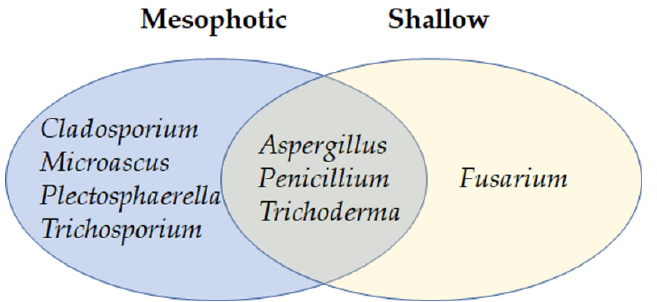
Figure 7. Presence of eight culturable fungal genera in specimens of Agelas oroides obtained from mesophotic depth (blue) and transplanted to shallow (10 m) depth.